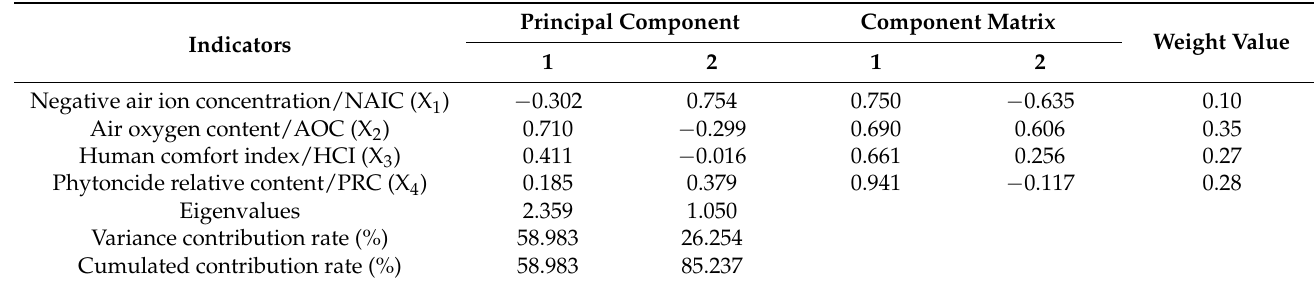
Table 2. Principal component score coefficient matrix and index weight of all indicators.